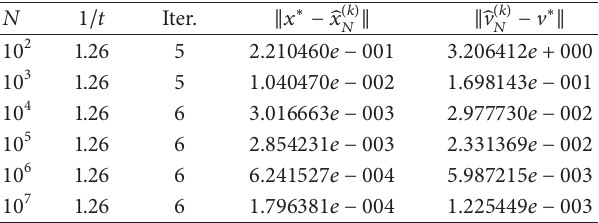
Table 5: The numerical results for Example